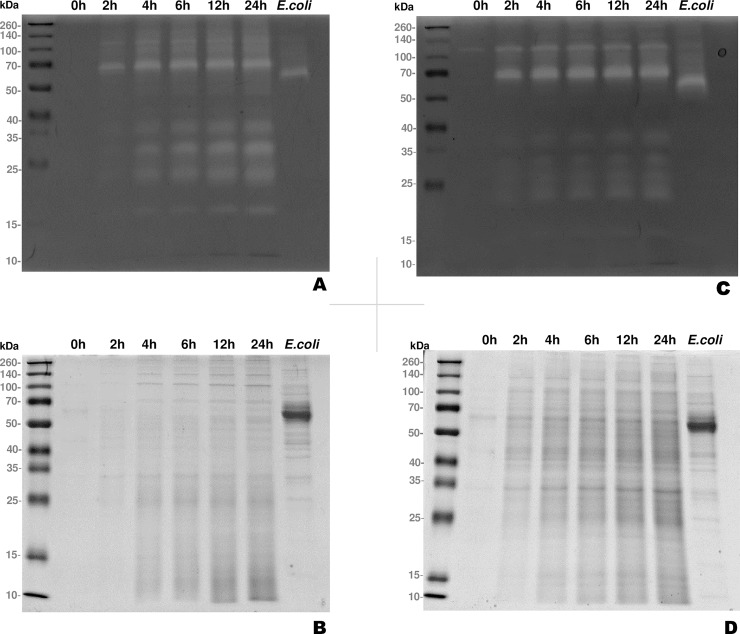
In vitro secretion kinetics assay demonstrating the time-dependent accumulation of proteins and proteases in the H. meleagridis exoproteome.(A) 1D-IGZ with the virulent H. meleagridis exoproteome. (B) Conventional 8% 1D SDS-PAGE gel with the virulent H. meleagridis exoproteome. (C) 1D-IGZ with the attenuated H. meleagridis exoproteome. (D) Conventional 8% 1D SDS-PAGE gel with the attenuated H. meleagridis exoproteome. E. coli 24h exoproteome serves as a control due to its’ presence in monoxenic co-cultivation.